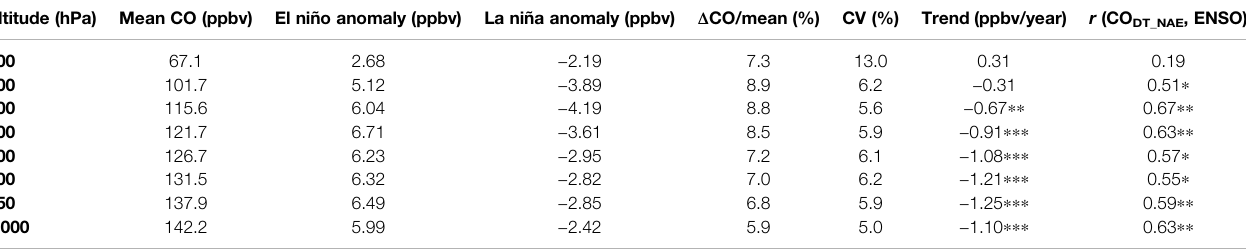
TABLE1| VerticalvariationsinCOconcentrations,COanomaliesinElNiñoandLaNiñayears,therelativedifferencesoftheanomalies,thecoef fi cientofvariation(CV=STD/ mean), trend of CO concentrations, correlation coef fi cients ( r ) between the ENSO index and detrended CO concentrations in the North Atlantic European region (CO DT_NAE ). “ Δ CO ” is the difference in CO concentrations between El Nino and La Nina years. Altitude (hPa) Mean CO (ppbv) El niño anomaly (ppbv) La niña anomaly (ppbv) Δ CO/mean (%) CV (%) Trend (ppbv/year) r (CO DT_NAE ,